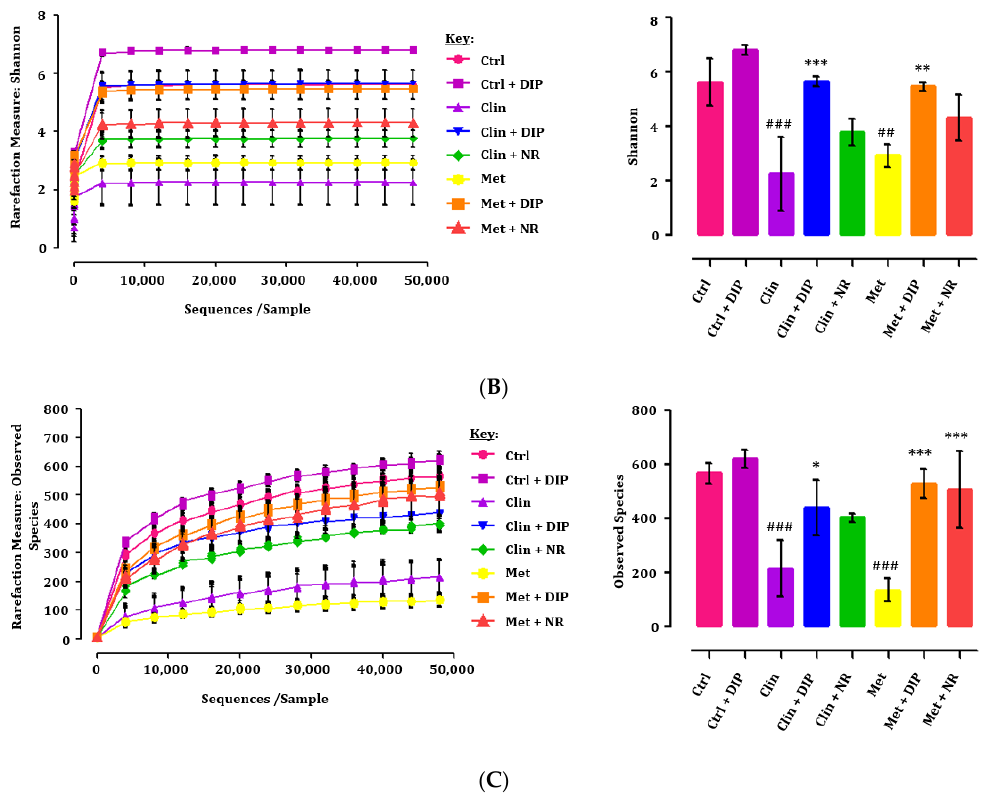
Figure 3. Rank abundance and rarefaction curves. ( A ) Rank abundance curve depicting the species richness and evenness. The x ‐ and y ‐ axis indicates the number of operational taxonomic units (OTUs) according to the relative abundance and species evenness respectively. The higher the species richness, the larger the curve on the x ‐ axis will be, and the smoother the curve, the more even the species distribution will be. ( B ) Rarefaction curves representing species abundance and diversity. Left: Shannon index value showing the microbial diversity and richness for each treatment group. Right: bar graph of the Shannon index values at maximum OTUs, where ## p < 0.01 and ### p < 0.001 compared to the control group (Ctrl), and ** p < 0.01 and *** p < 0.001, compared to the antibiotic ‐ treated groups (Clin/Met), evaluated by using one ‐ way analysis of variance (ANOVA) followed by Tukey’s multiple comparison test. Bar graph depicting mean ± standard error of mean (SEM) ( n = 3); ( C ) Observed species depicting species diversity and evenness. Left: observed species showing the microbial diversity and richness for each treatment. The x ‐ axis shows the number of valid sequences per sample and the y ‐ axis shows the observed species (OTUs). Each curve in the graph represents a different group and is shown in a different color. Right: bar graph of the observed species at maximum OTUs, ### p < 0.001 compared to the control group (Ctrl), and * p < 0.05 and *** p < 0.001 compared to the antibiotic ‐ treated groups (Clin/Met), evaluated by using one ‐ way analysis of variance (ANOVA) followed by Tukey’s multiple comparison test. Data presented here is the mean ± standard error of mean (SEM) ( n = 3).